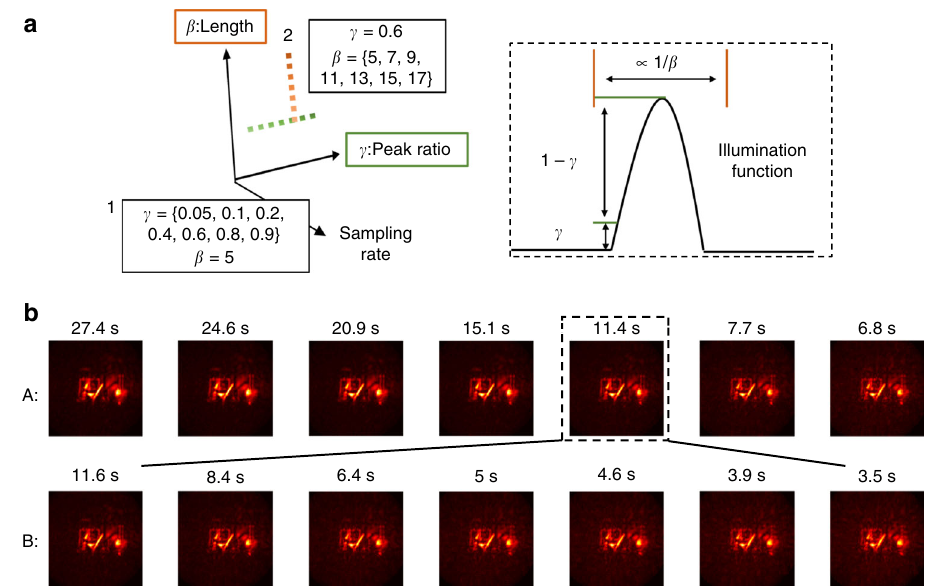
Fig. 9 Virtual illumination function design space and reconstruction speed. a The virtual illumination function design space and b the corresponding design parameters with reconstructions and their run times. As shown in a , considering the peak ratio γ and the temporal envelope length D = β ⋅ λ (characterized by how many modulation cycles fi t inside the envelope) for the illumination function, we plot each corresponding reconstruction and processing time for the Of fi ce Scene dataset with 20 ms exposure in b . The peak ratio γ coef fi cient is used for thresholding in the Fourier domain. Overall, the more Fourier components used during the reconstruction, the better the noise reduction and the longer the calculation